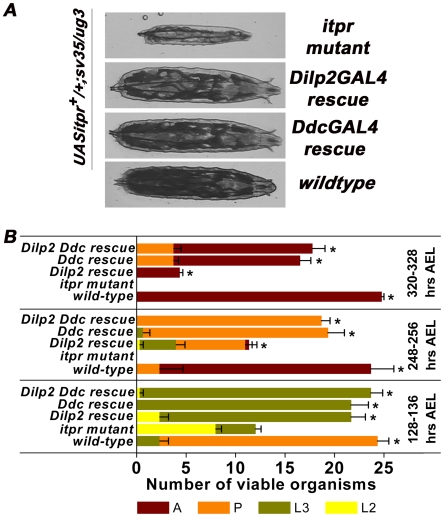
Growth and lethality defects in itpr mutant larvae can be rescued by UASitpr+ expression in IPCs.(A) Third instar larvae at 120 hrs After Egg Laying (AEL). UASitpr+/+;itprsv35/ug3 are significantly reduced in size and fat body content. Both Dilp2GAL4 and DdcGAL4 rescued larvae start wandering at this stage and appear similar to wild-type (Canton-S) controls. (B) Wild-type (Canton-S) and animals of all rescue conditions grown at 25°C survive better as compared to itpr mutants (UASitpr+/+;itprsv35/ug3) grown under the same conditions at later times after egg laying (*p<0.05; Student's t-test). For each time interval and genotype, 75 animals were screened in 3 batches of 25. Each bar represents the total viability of the indicated genotype. The colored subdivisions in each bar represent the number of larvae developing to later larval, pupal (P) or adult (A) stages. The survival profile of DdcGAL4 rescued animals (UASitpr+/+; DdcGAL4/+; itprsv35/ug3) is better than that of Dilp2GAL4 rescued condition (UASitpr+/+; Dilp2GAL4/+; itprsv35/ug3). Expression of UASitpr+ simultaneously with Dilp2GAL4 and DdcGAL4 (UASitpr+/+; Dilp2GAL4/DdcGAL4; itprsv35/ug3) does not improve survival beyond that observed with only DdcGAL4. Results are expressed as mean±SEM.